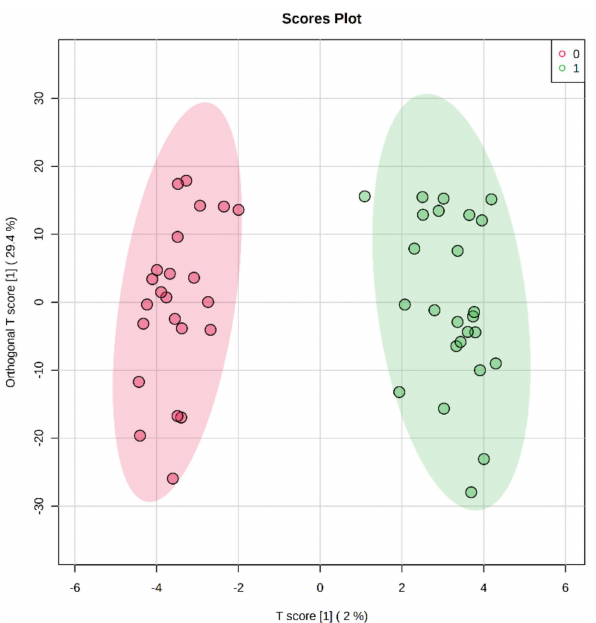
Figure 1. Orthogonal Partial Least Square Discriminant Analysis (OPLS-DA) scores plot of T score [1] versus orthogonal T score [1] result showing the separation of study groups. Pink nodes (0) represent cognitively healthy people, and green nodes (1) represent patients with Alzheimer’s